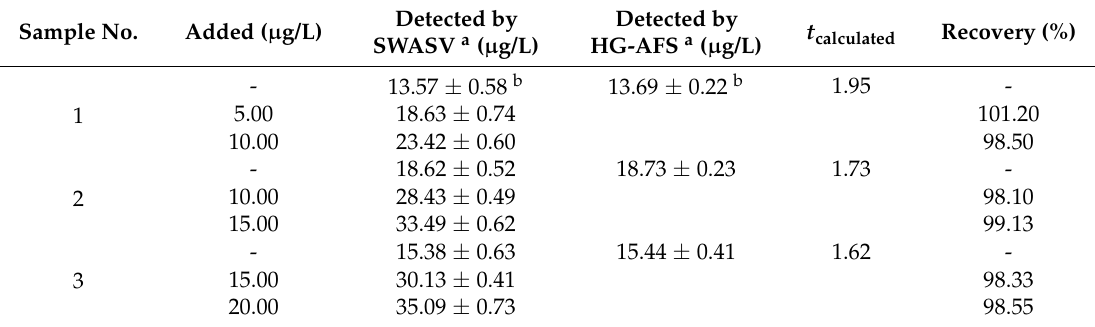
Table 2. Results of the detection of As(III) in soil sample extracts. Detected by Detected by Sample No. Added ( µ g/L) SWASV a ( µ g/L) HG-AFS a ( µ